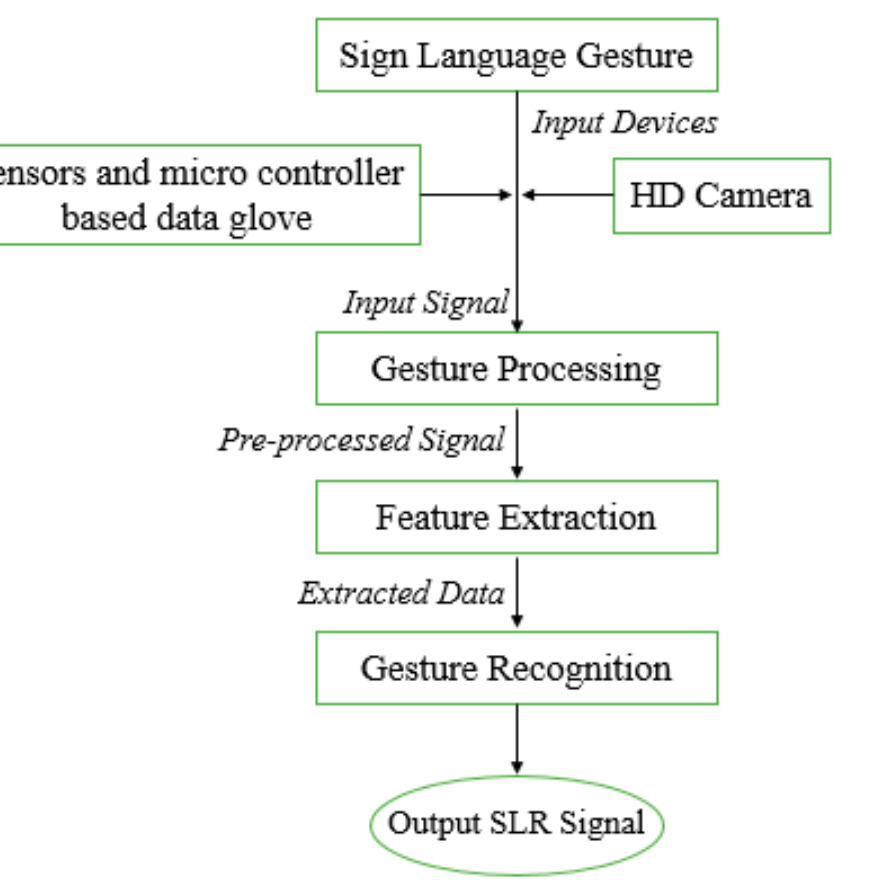
Figure 3. Processing steps for the hybrid SLR